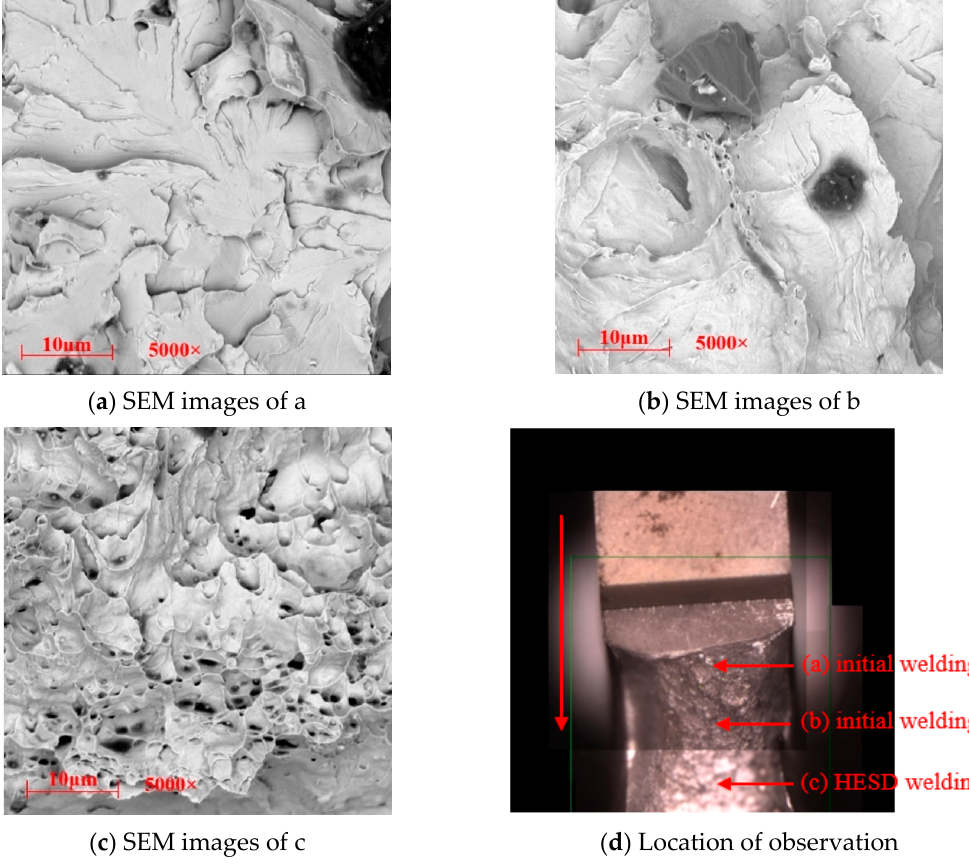
Metals 2020 , 10 , x FOR PEER REVIEW Figure 21. SEM images of the compact tensile specimen fracture. Figure 21. SEM images of the compact tensile specimen fracture.